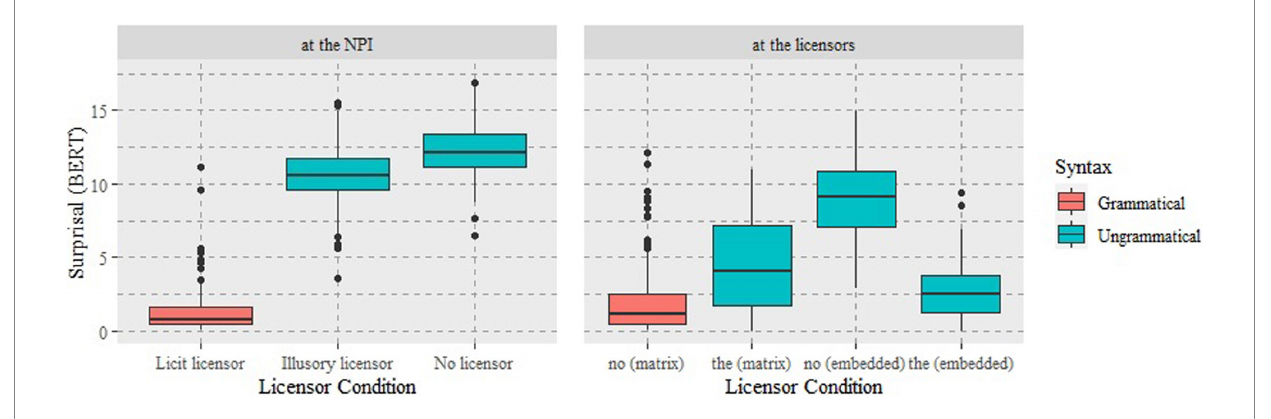
FIGURE 1 The distribution of surprisal at the NPI and at the licensor positions in Experiment